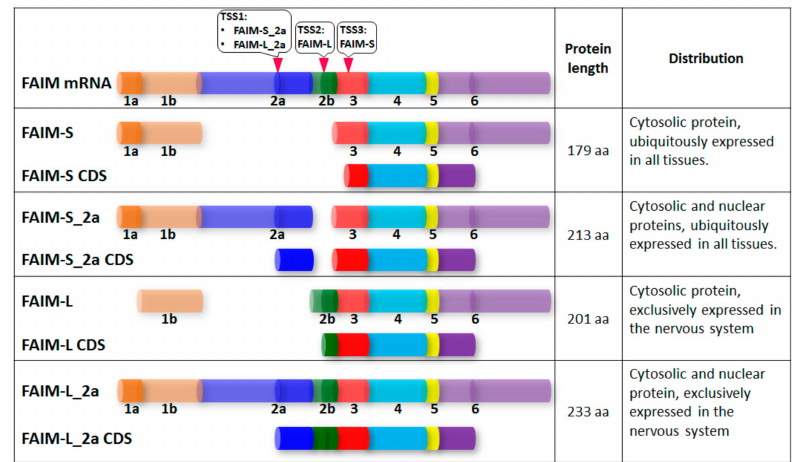
Figure 1. Structure and comparison of four human Fas apoptosis inhibitory molecule (FAIM) isoforms. Schematic representation of FAIM gene structure shown with exon 1a, 1b, 2a, 2b, 3, 4, 5 and 6. In contrast to the 5 (cid:48) and 3 (cid:48) untranslated regions (UTRs), coding sequence (CDS) regions are indicated with a darker color. TSS, Transcriptional start